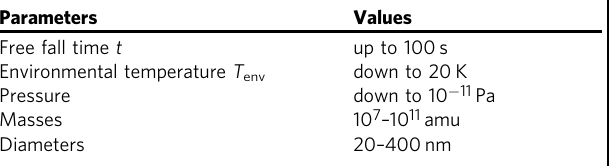
Table 1 Possible mission ’ s